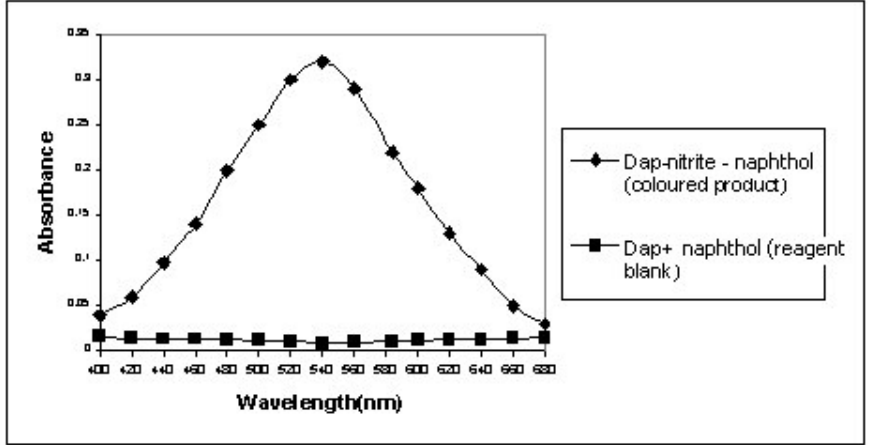
Figure 1 Absorption Spectra of the Reaction Product of Nitrite ( 0.4 m G Ml -1 ) and the Corresponding Reagent